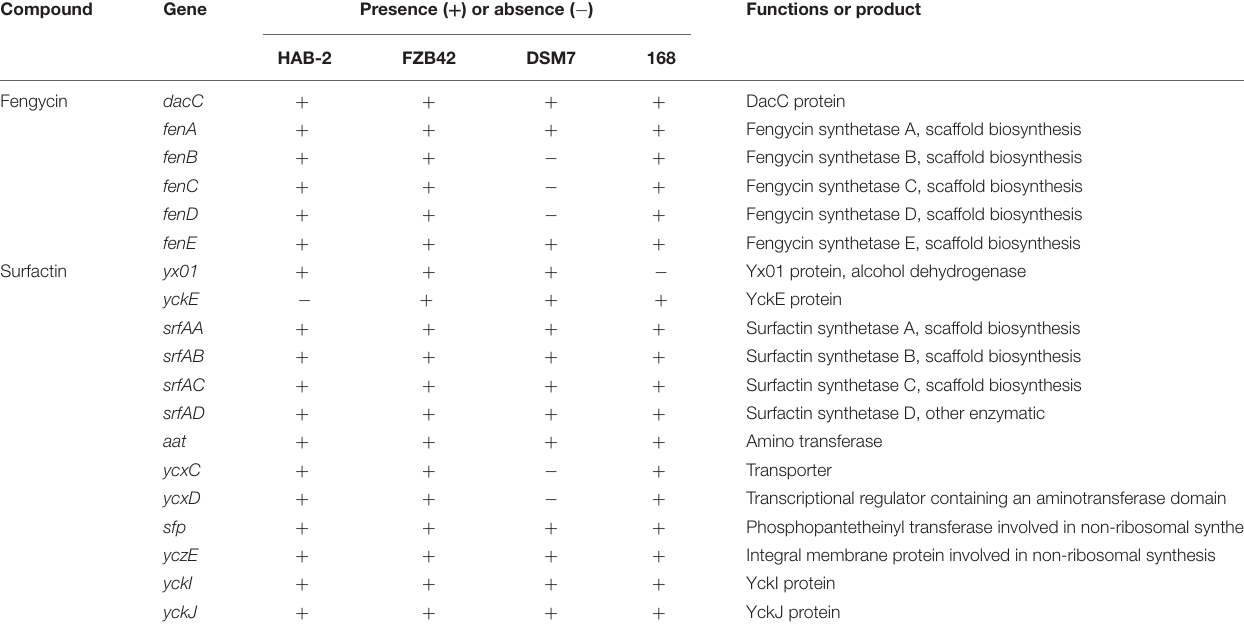
TABLE 3 | Core genes involved with fengycin and surfactin in B. velezensis HAB-2, B. velezensis FZB42, B. amyloliquefaciens DSM7, and B. subtilis 168. Compound